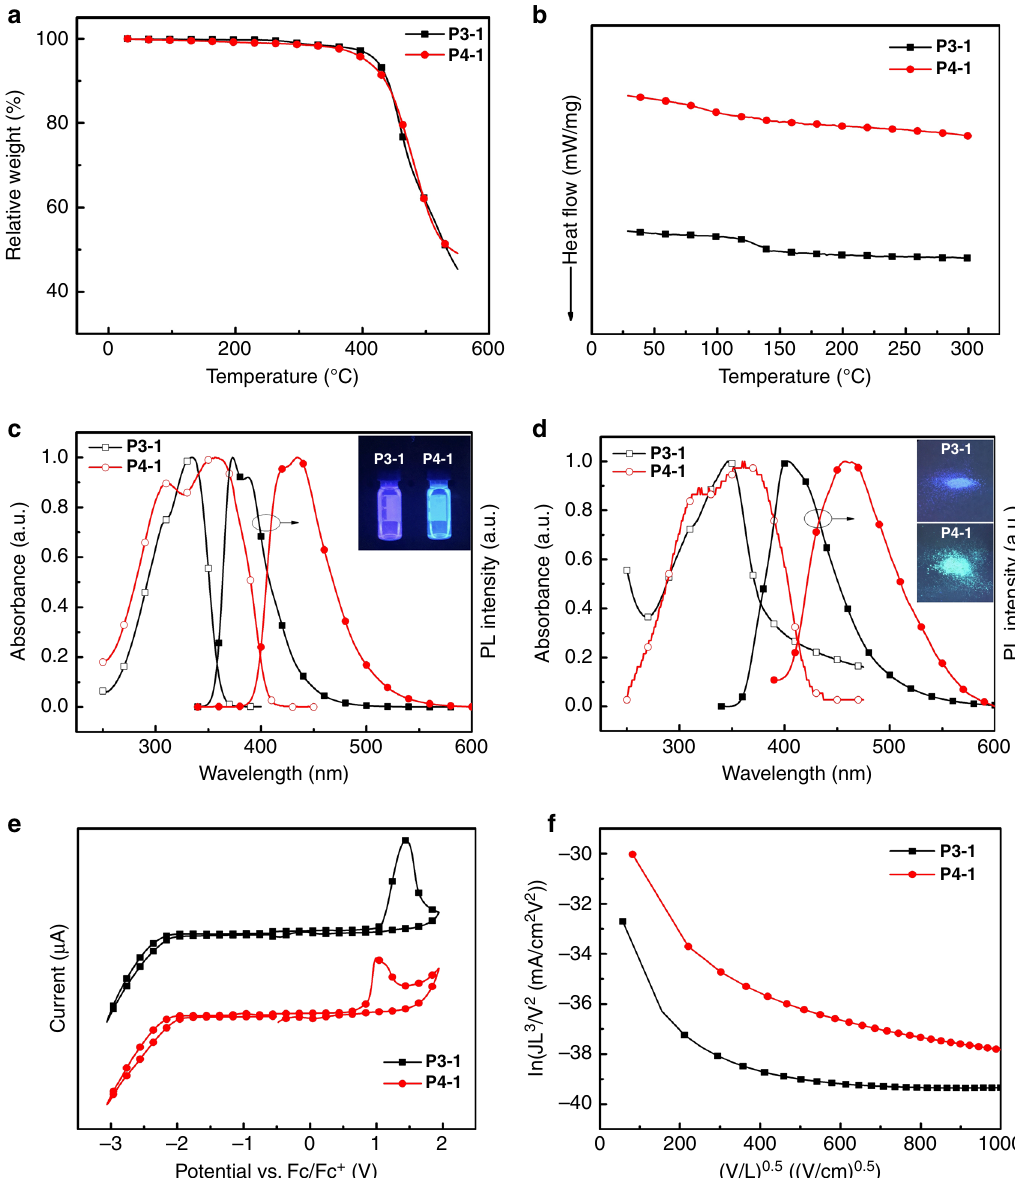
Fig. 7 Polymer characterization. a TGA curves of the co-polymers P3-1 and P4-1 . b DSC curves of the co-polymers P3-1 and P4-1 . c Normalized UV-Vis absorption and PL spectra of co-polymers P3-1 and P4-1 in THF solution and photographs of polymer photoluminescence under 365 nm light in THF solution. d Normalized UV-Vis absorption and PL spectra of co-polymers P3-1 and P4-1 in fi lm state and photographs of polymer photoluminescence under 365 nm light in solid state. e Cyclic voltammograms of the oxidation curves in dichloromethane and reduction curves in THF for co-polymers P3-1 and P4- 1 . f Current density – voltage ( J – V ) characteristics of hole-only devices with structure of ITO/PEDOT:PSS(30 nm)/ P3-1 or P4-1 (30 nm)/MoO 3 (8